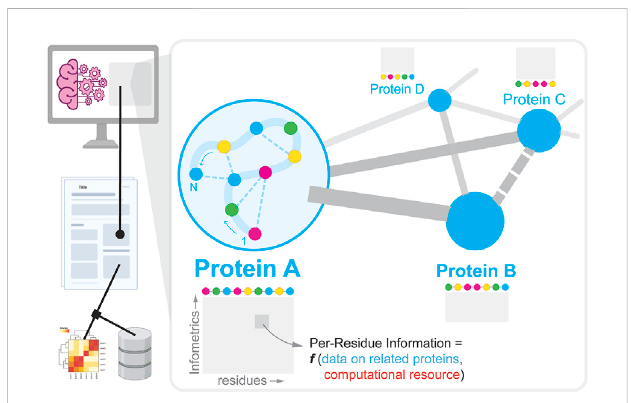
FIGURE 1 Overview of how experimental data describing a protein molecule and its interactions (inset) is reported in literature, and extracted using natural language processing to create datasets to support subsequent machine learning/AI-guided protein engineering